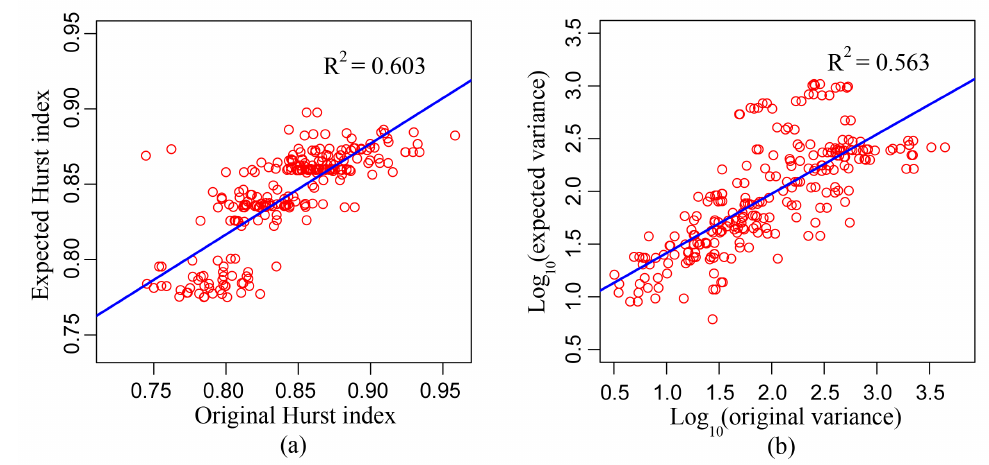
Figure 7. ( a ) Linear association between the original and expected Hurst index values and ( b ) Common logarithm of original and expected variance